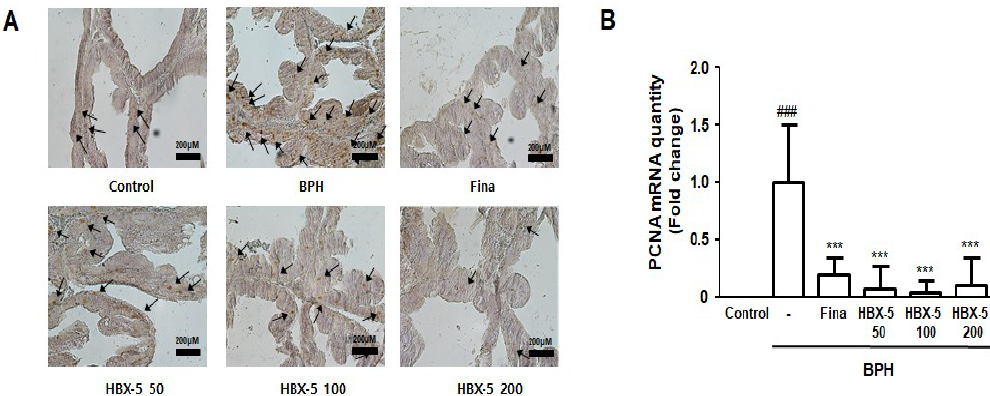
Figure. 6. Effect of HBX-5 administration on the expression of PCNA. ( A ) The manifestation of PCNA in prostate tissues was performed by IHC staining. The arrows indicate immunoreactivity of PCNA in the representative pictures of each group. ( B ) Expression of mRNA for PCNA in prostate tissues was analyzed by quantitative real-time PCR. The data presented as the mean ± standard error of the mean of 10 rats per group ( ### p < 0.001 vs. Con group; *** p < 0.001 vs. BPH group). Control, Control group; BPH, rats with BPH group; Fina, rats with BPH group treated with 5 mg/kg/day of finasteride; HBX-5 50, rats with BPH group treated with 50 mg/kg/day of HBX-5; HBX-5 100, rats with BPH group treated with 100 mg/kg/day of HBX-5; HBX-5 200, rats with BPH group treated with 200 mg/kg/day of HBX-5.